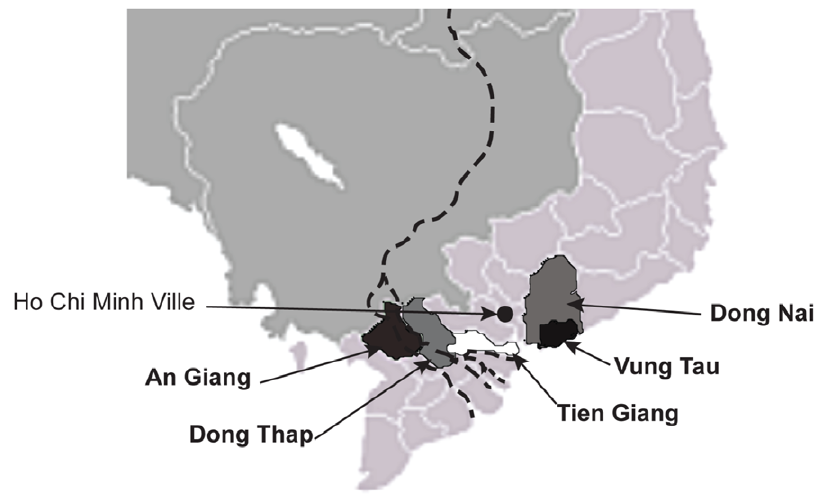
Figure 1. Vietnamese cities of Mekong Delta taking part to the study.